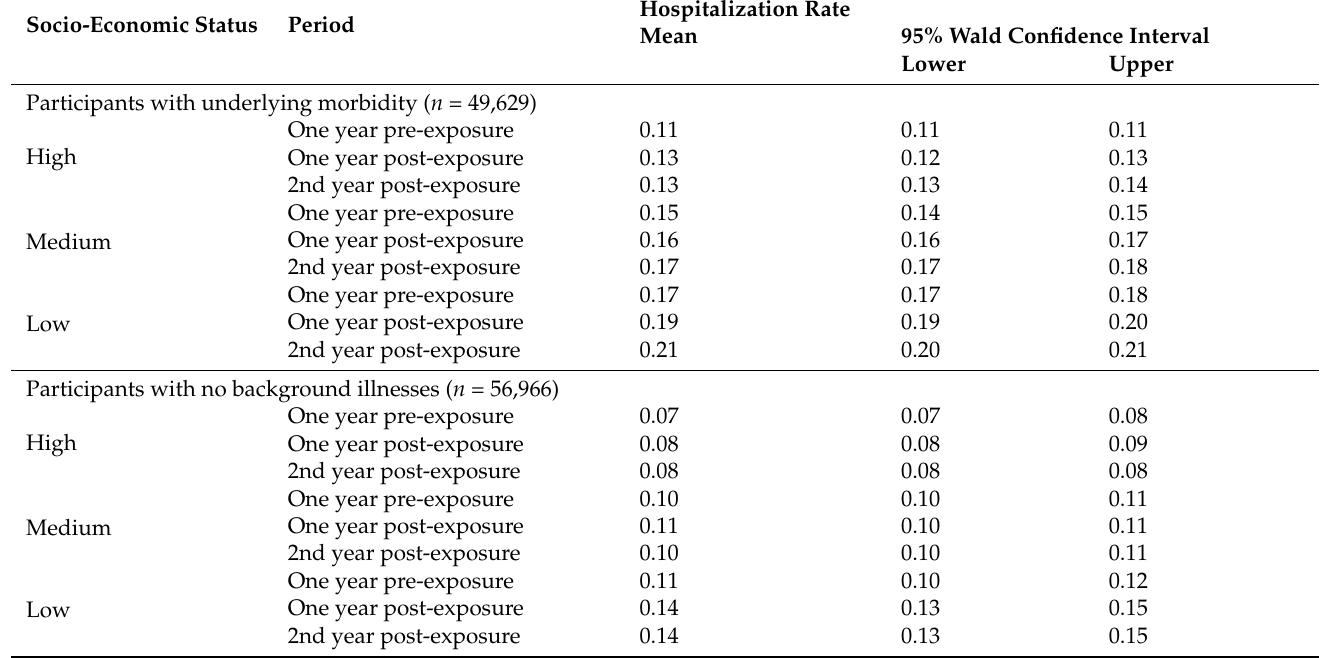
Table A1. Estimated means of hospitalization rates during study periods based on a Poisson regres- sion